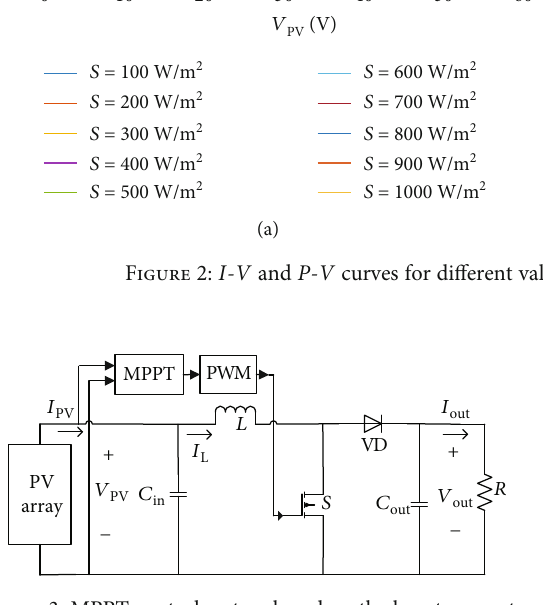
Figure 3: MPPT control system based on the boost